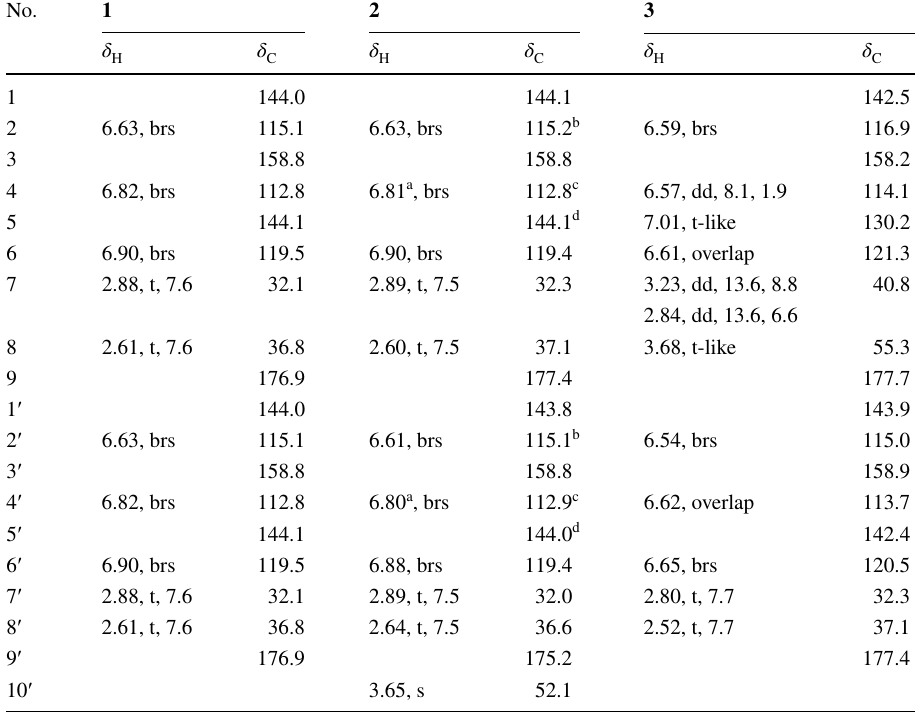
Table 1 1 H (600 MHz) and 13 C NMR (150 MHz) data of 1 – 3 ( δ in ppm, J in Hz, in methanol- d 4 )